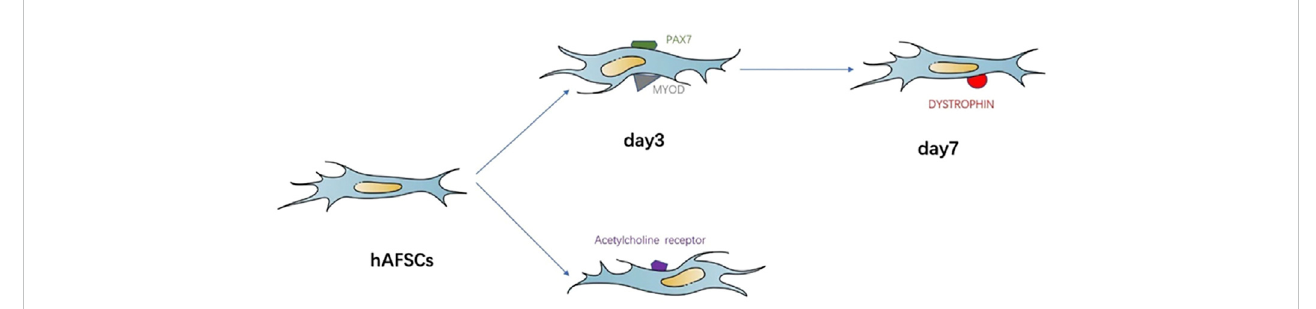
Simpli fi ed representation of the MSCs in myogenic differentiation and neurogenic